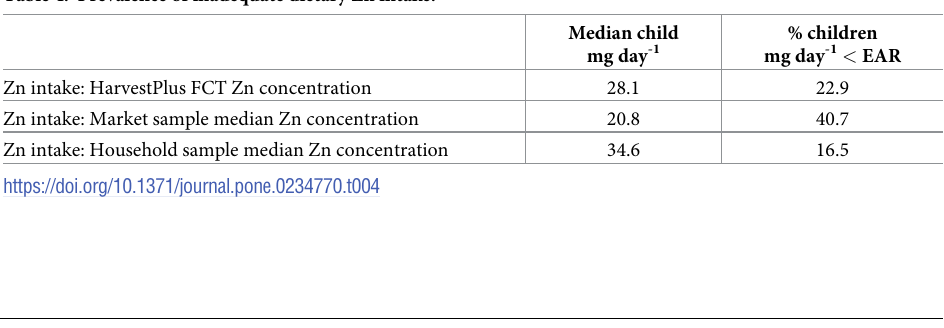
The values reported here are based on a Food Frequency Questionnaire, which was designed and validated only to assess Zn intake. Therefore, total calorie intake is not represented and the relative contribution of each food group to total calorie intake may vary from the values reported here. Cereal: Maize, millet, sorghum, rice, or wheat. Nuts, legumes and seeds: beans, groundnut, cowpeas, pigeon peas, or soy peas. Tubers: sweet potato or cassava. Animal- sourced foods: eggs, fish, beef, or milk.